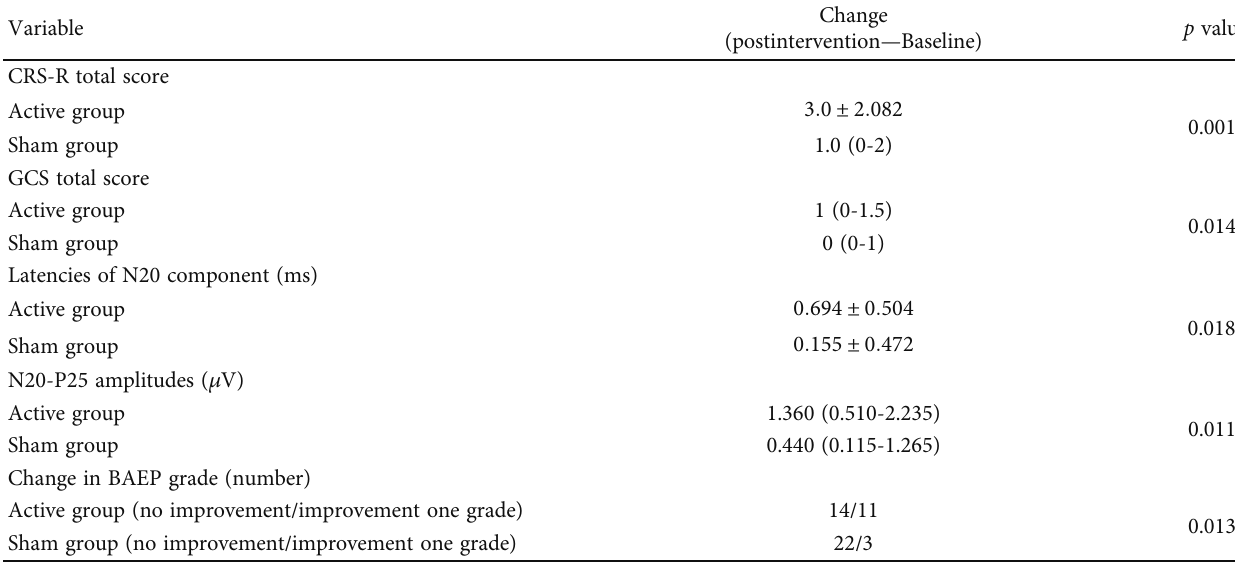
Table 3: Changes in measured parameters from baseline to postintervention for patients in the active and sham groups. Variable